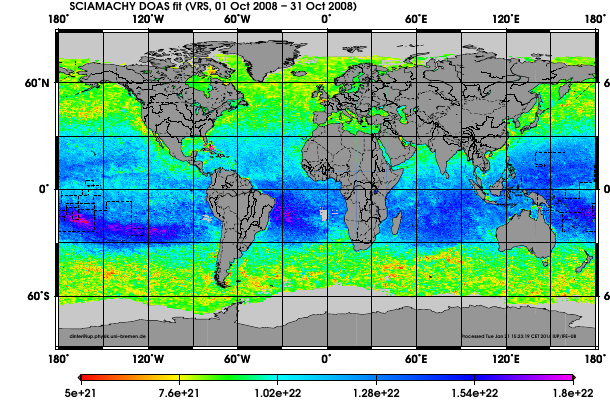
Figure 12. Global map of the depth integrated scalar irradiance E unc 0 at 390–444.5nm from DOAS VRS weighting function fits in unit of photonss − 1 m − 1 without SZA correction. Red shows low and blue-magenta high E 0 values. Note the different colour table to Fig. 13.